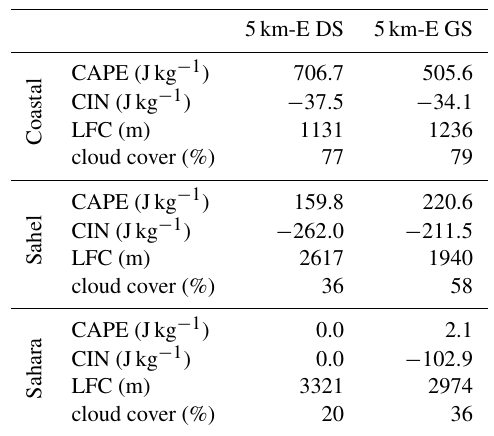
Table 2. JAS mean values of 12:00UTC CAPE, CIN and JAS mean level of free convection (LFC), and total cloud cover for the coastal, Sahel, and Sahara region (Fig. 1) for the 5km-E DS and GS simu-